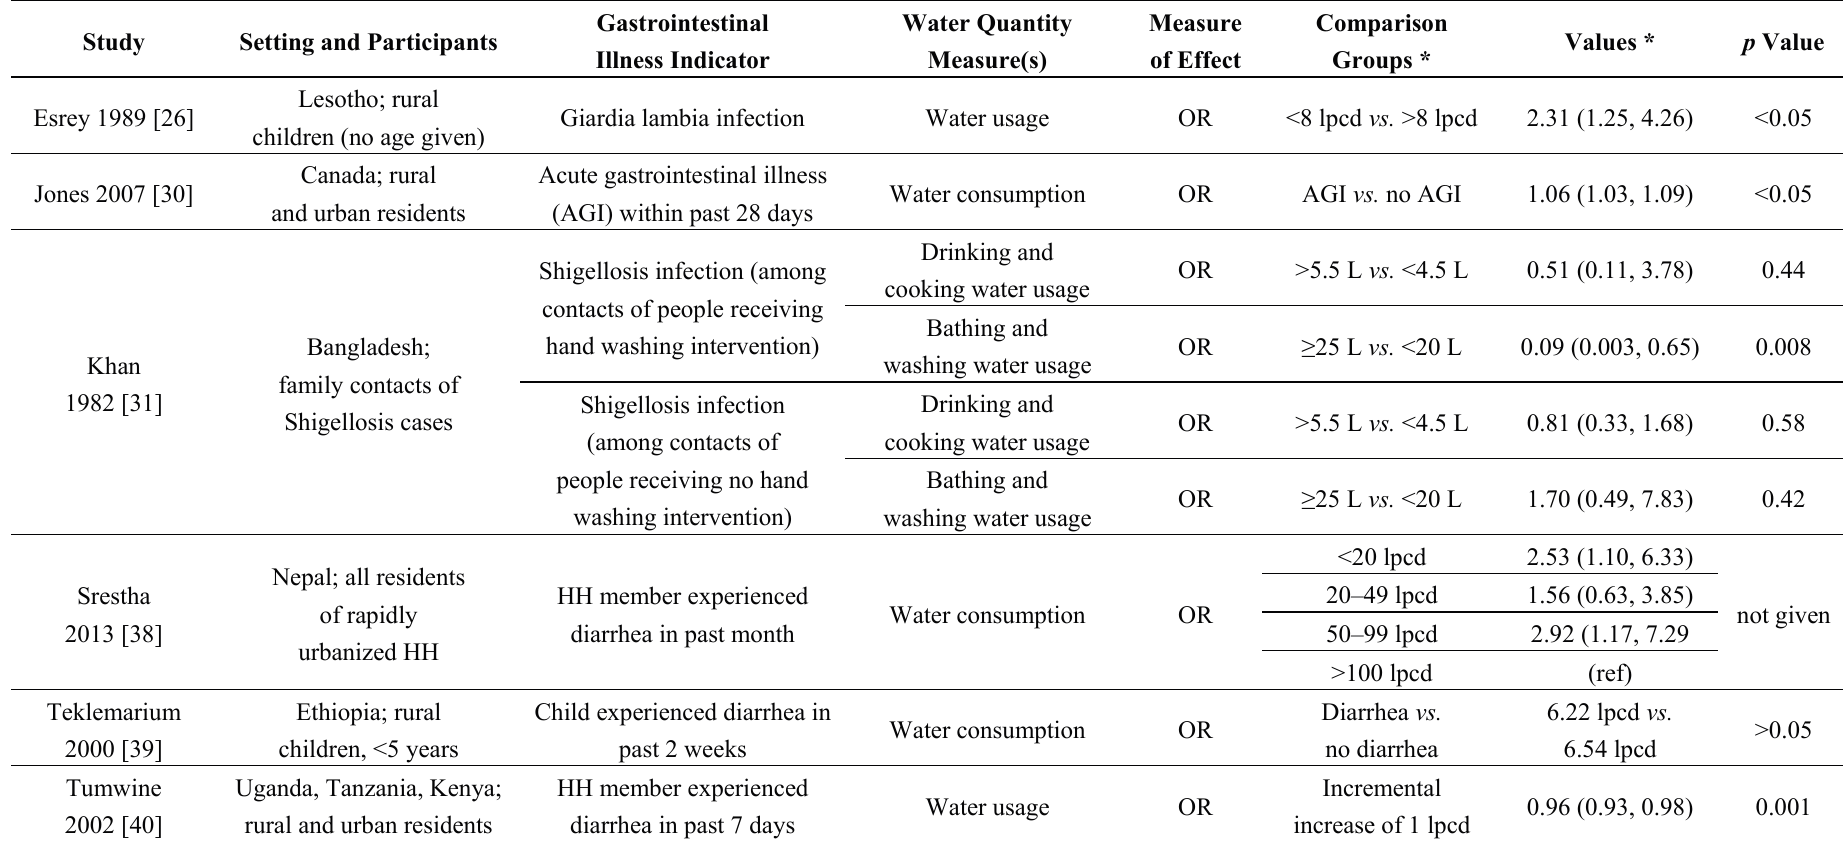
Table 3. Effects of Water Quantity on Gastrointestinal (GI) Illnesses